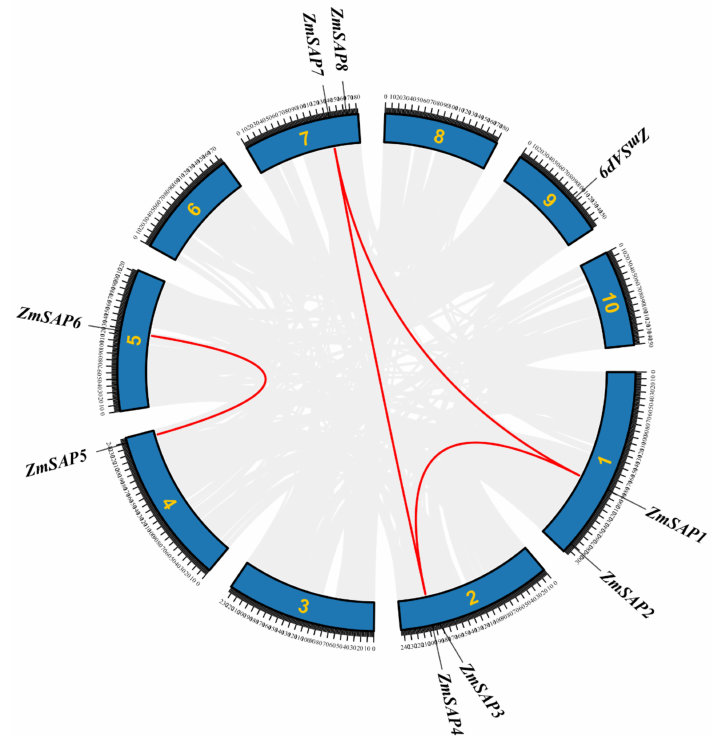
Figure 3. SAP collinearity analysis within the maize genome. Genome-wide collinearity genes are marked with gray lines and ZmSAP pairs of whole genome duplication are marked with red lines.